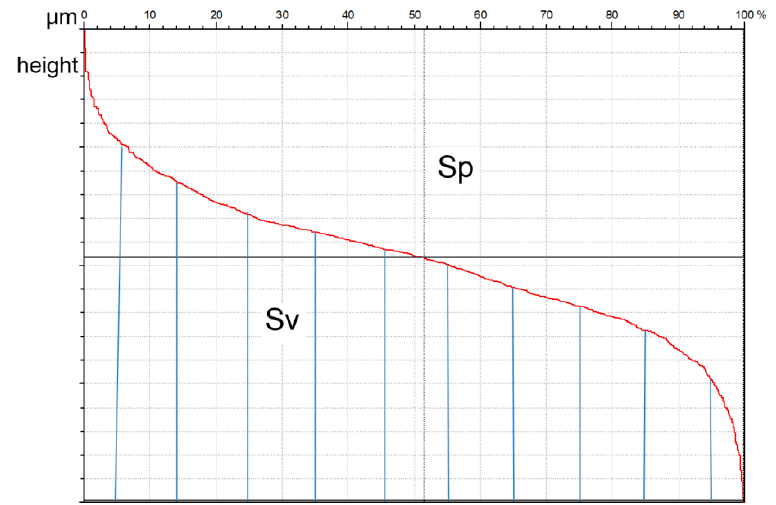
Figure 6. Graphical interpretation of Sp and Sv parameters.